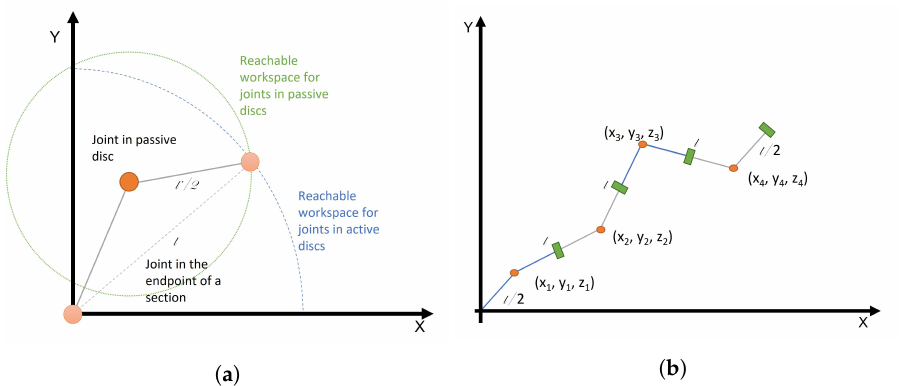
Figure 19. Defining virtual sections for inverse kinematic modelling. ( a ) Differences between work spaces. ( b ) Discreet sections for inverse kinematic